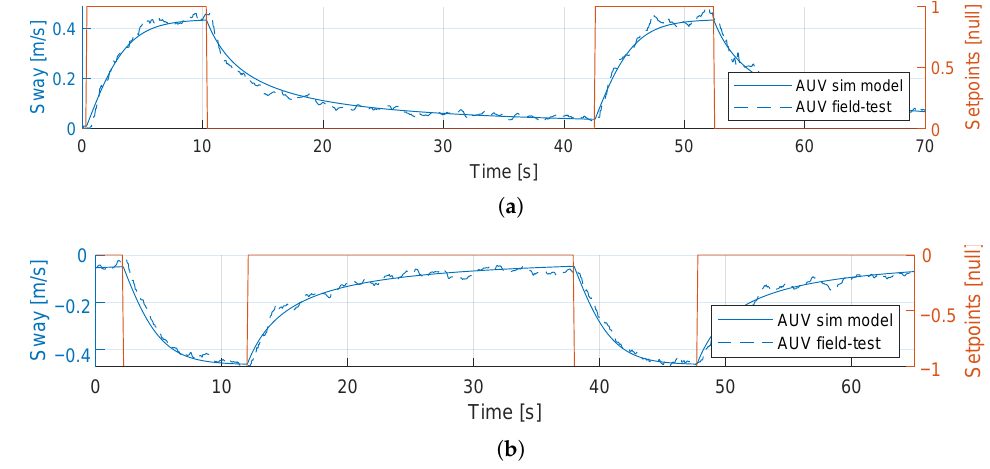
Figure 5. Model-validation using parameter estimation for the Girona500: ( b ) Sway (right side) motion (thruster setpoints equal to 1.00), ( b ) Sway (left side) motion (thruster setpoints equal to −